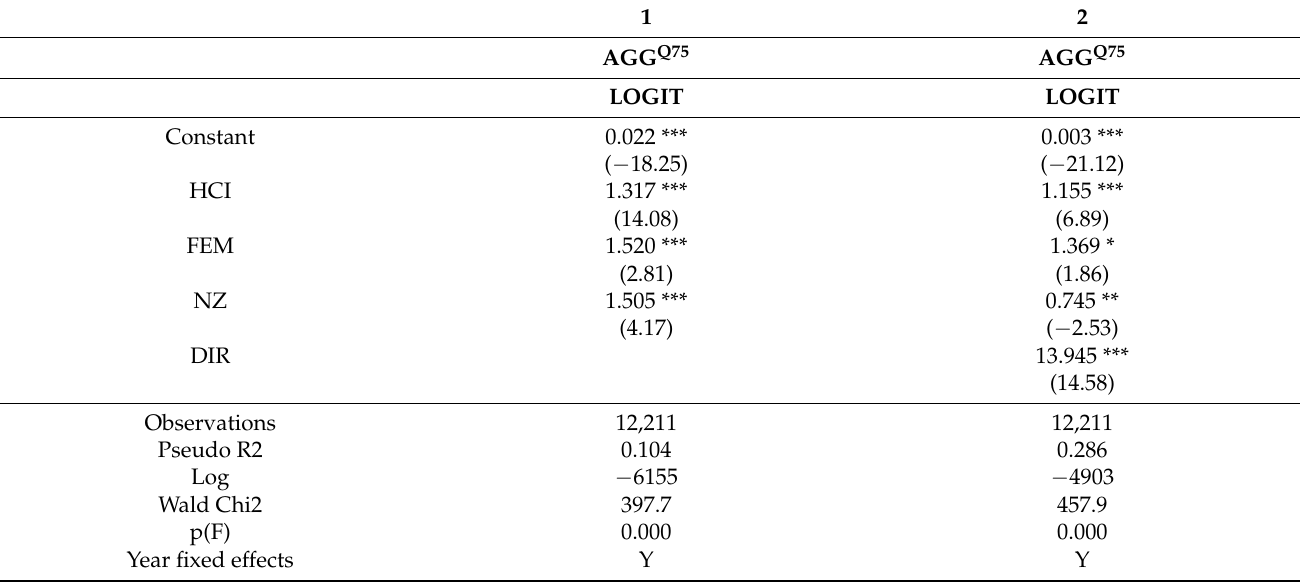
Table 7. Logit regressions for the relationship between human capital and social capital—top